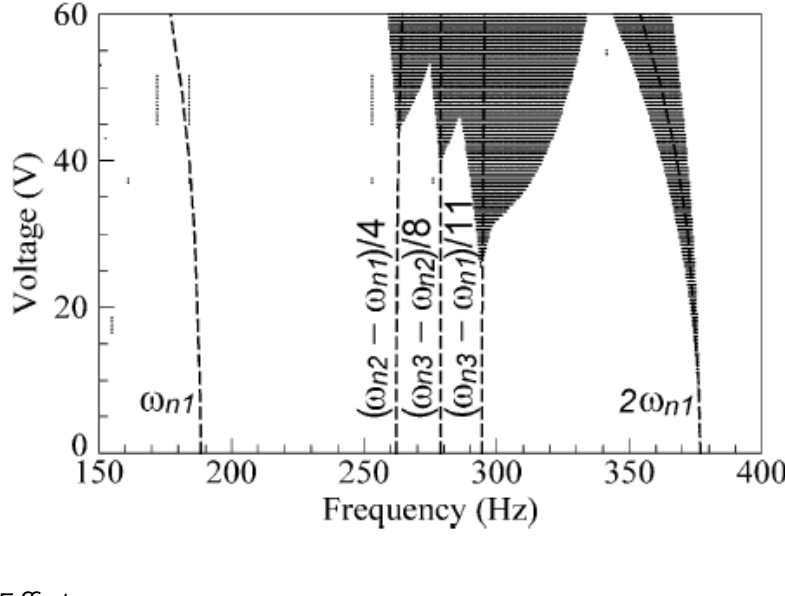
Figure 8. Dynamical instable region of a microcantilever subjected to an AC voltage